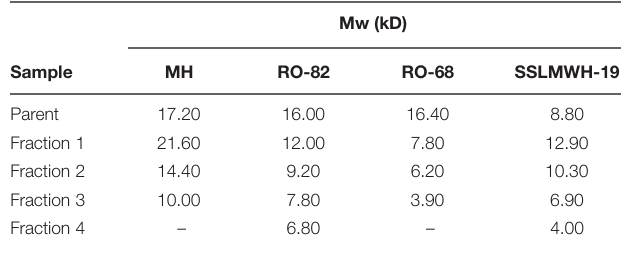
TABLE 1 | Average molecular weight (Mw) rounded to 100s D of the fractions obtained from four different heparin types: the unmodified Mucosal Heparin (MH), the 30% glycol-split RO-82, the partially desulfated 42% glycol-split RO-68 and the ovesulfated